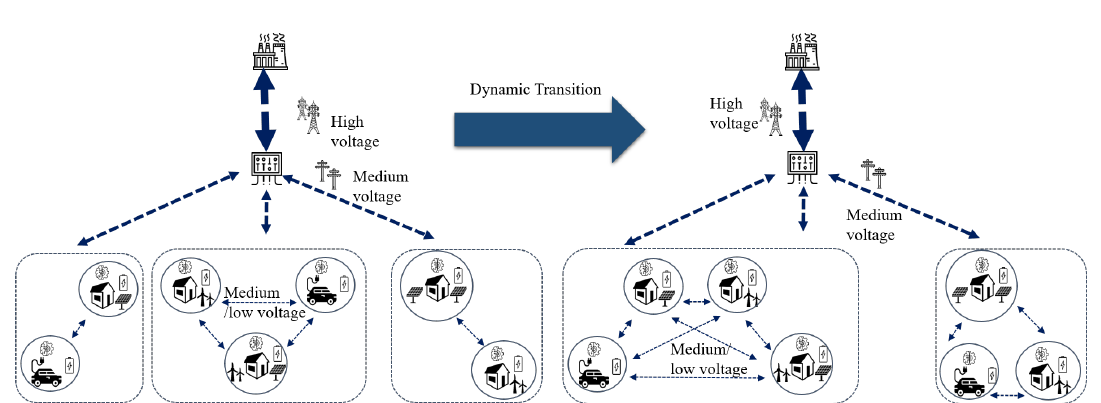
Figure 1. Block diagram of a system of MGs. Due to the dynamicity of the system, different coalitions can be formed during each